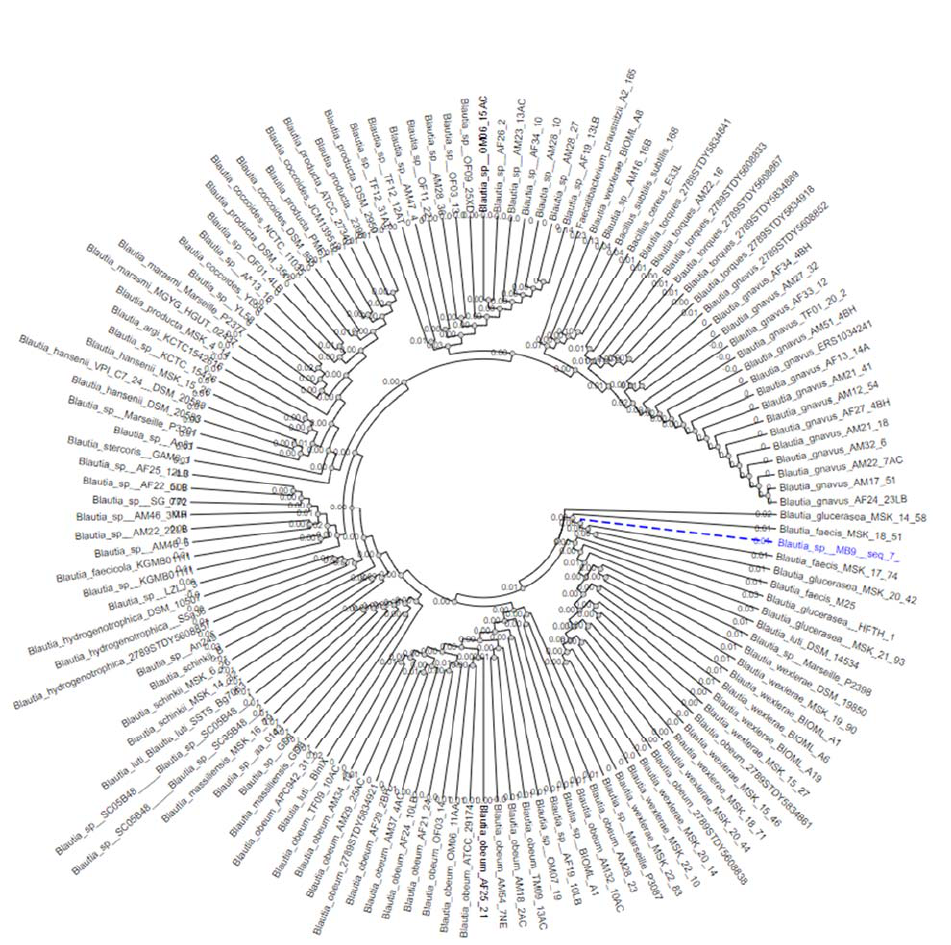
Figure 2. Phylogenetic tree of Blautia species from IMG, NCBI, and PATRIC databases.